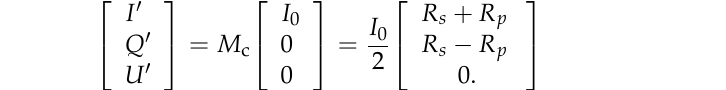
Figure 12. ( a ) Curve of Rs with respect to wavelength, ( b ) Curve of Rp with respect to wavelength. Thus, the Muller matrix of three channels is derived. When the incident light is unpolarized, the Stokes vector of the outgoing light passing through the UV collimator is: